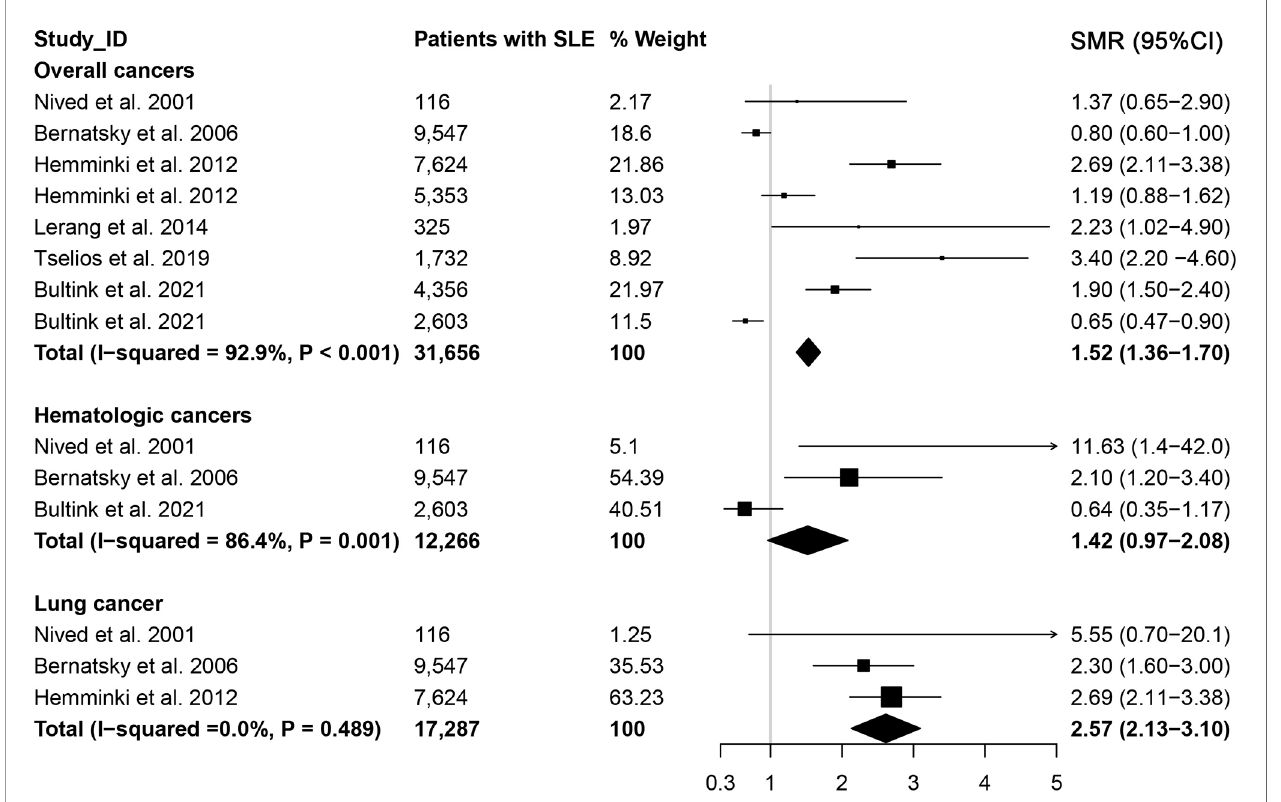
FIGURE 3 | Overall cancer and site-speci fi c cancer mortality in patients with systemic lupus